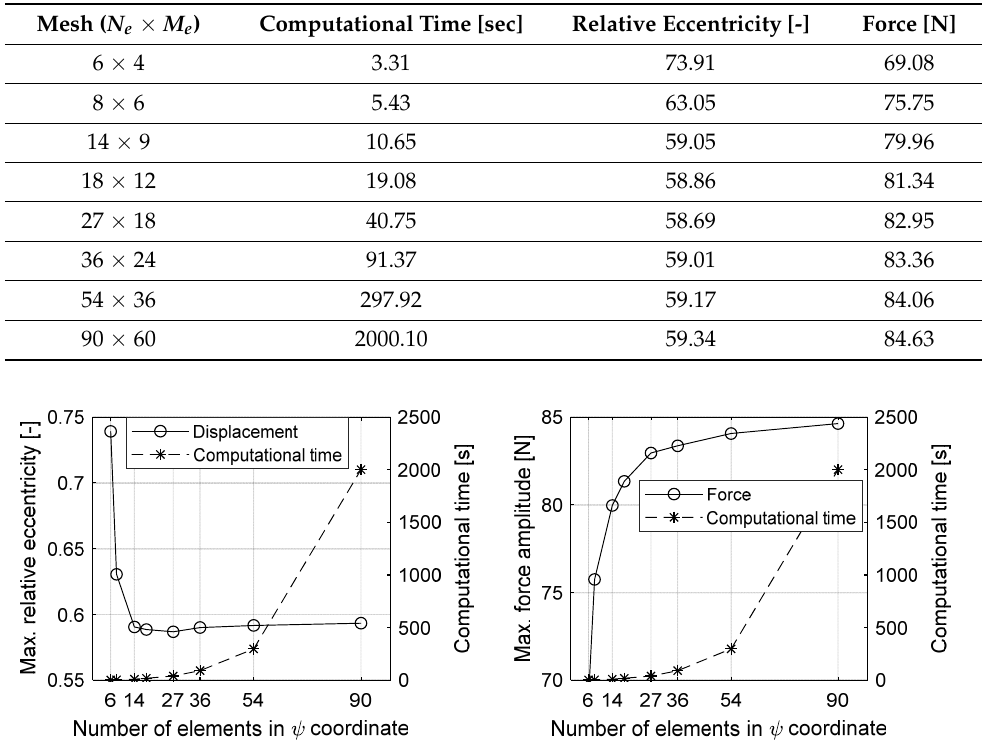
Figure 16. The orbits and bearing forces from the two simulation models. 4.2. Transient Responses 4.2.1. Displacements and Bearing Reaction Forces The simulation and experimental results with different unbalance magnitudes and angular acceleration rates are presented. Figures 17 and 18 display the displacements and bearing forces of the upper and lower bearings with 5.9 × 10 − 3 kg·m unbalance magnitude and 2 π rad/s 2 angular acceleration. The responses from both simulation and experiment show a similar trend, and all the displacements and bearing forces increase with the rotor speed. However, unlike in the simulation, an amplitude peak appears close to 1000 rpm in the experiment, which is due to the structural resonance of the test rig. In the experi- ment, the upper and lower bearings perform in the same way, and with slight differences. Excluding responses close to 1000 rpm, the maximum deviation of displacement and force amplitude between the two bearings are 0.0122 mm (18%) and 39.2 N (10%). Figures 19 and 20 show the orbits and bearing forces for three ranges of rotor speeds, i.e., (500–600) rpm, (1250–1350) rpm, and (2250–2350) rpm. Both the simulation and ex- perimental results show similar patterns. The periodically varying bearing coefficients on and between pads produce orbits and forces with peaks and valleys. For lower unbalance magnitude and rotor speed, however, the shape of the orbits looks relatively circular. This -0.1